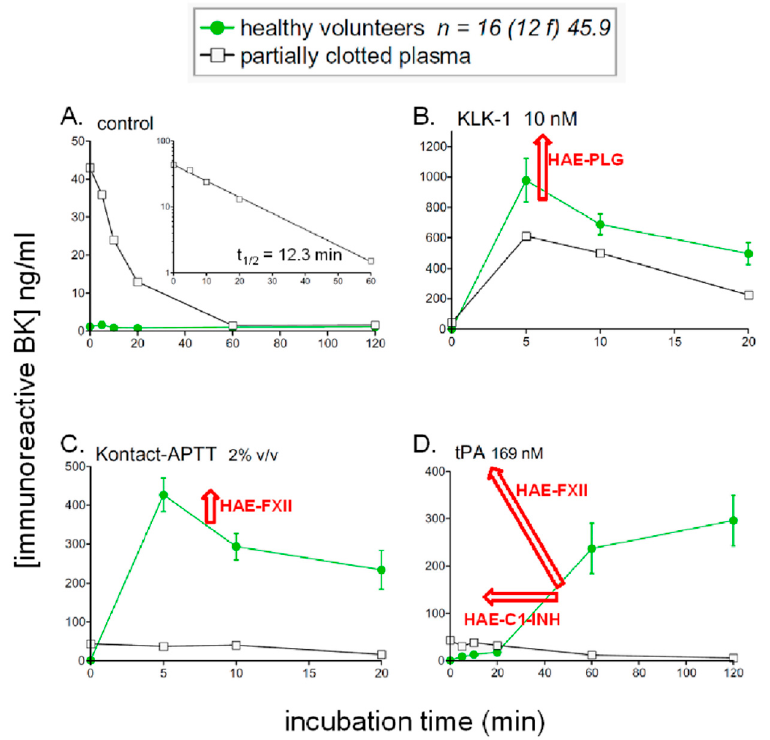
Figure 5. Kinetics of iBK concentrations as a function of time and stimulation in samples of normal plasma incubated at 37 ◦ C in the presence of enalaprilat (130 nM). Panels represent di ff erent forms of in vitro stimulation added to plasma at time zero: ( A ) control; ( B ) KLK-1 10 nM; ( C ) Kontact-APTT ™ 2% v / v ; ( D ) tPA 169 nM. The data is from the fusion of the 2 control groups (healthy volunteers) from [18,44]. The average age is 45.9 and 12 females are represented in this group of 16 subjects. Indications of significant variations induced by specific HAE subtypes are indicated by red arrows. Measurements made from a partly clotted plasma sample are also shown: in the presence of enalaprilat but no other stimulant, the sizeable concentration of BK at time zero decreases according to a first-order elimination kinetics (panel A, t 1 / 2 12.3 min,